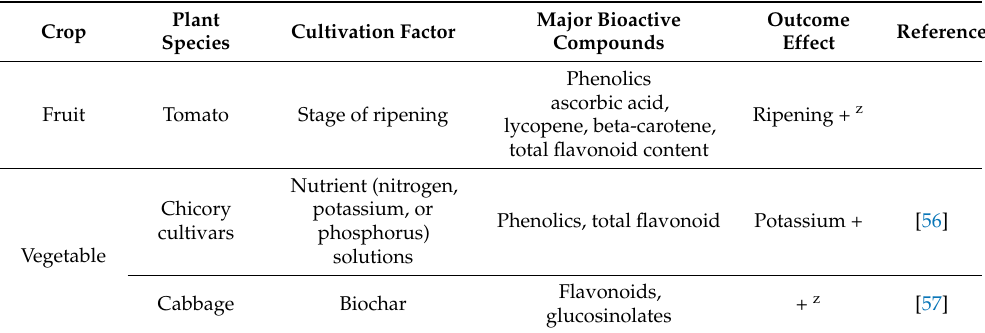
Table 3. Research studies to improve bioactive compound levels in plant foods in building-integrated, uncontrolled urban